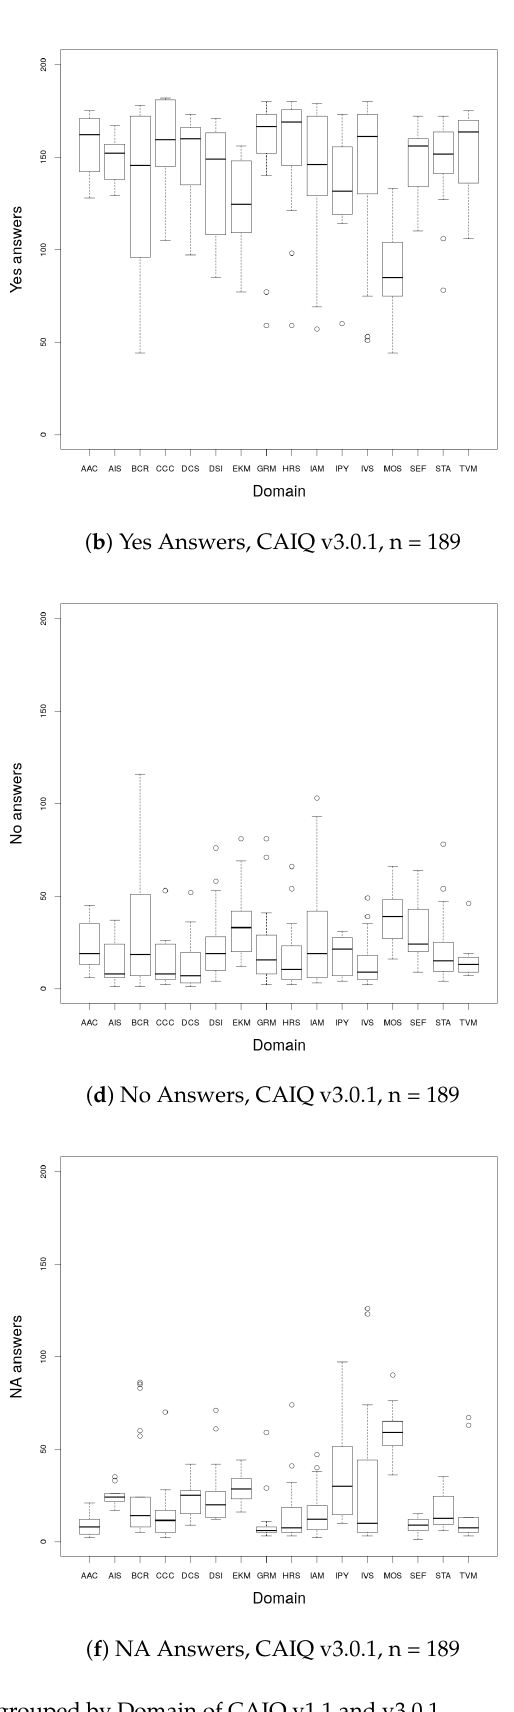
Figure 4. Distribution of Answers per Question grouped by Domain of CAIQ v1.1 and